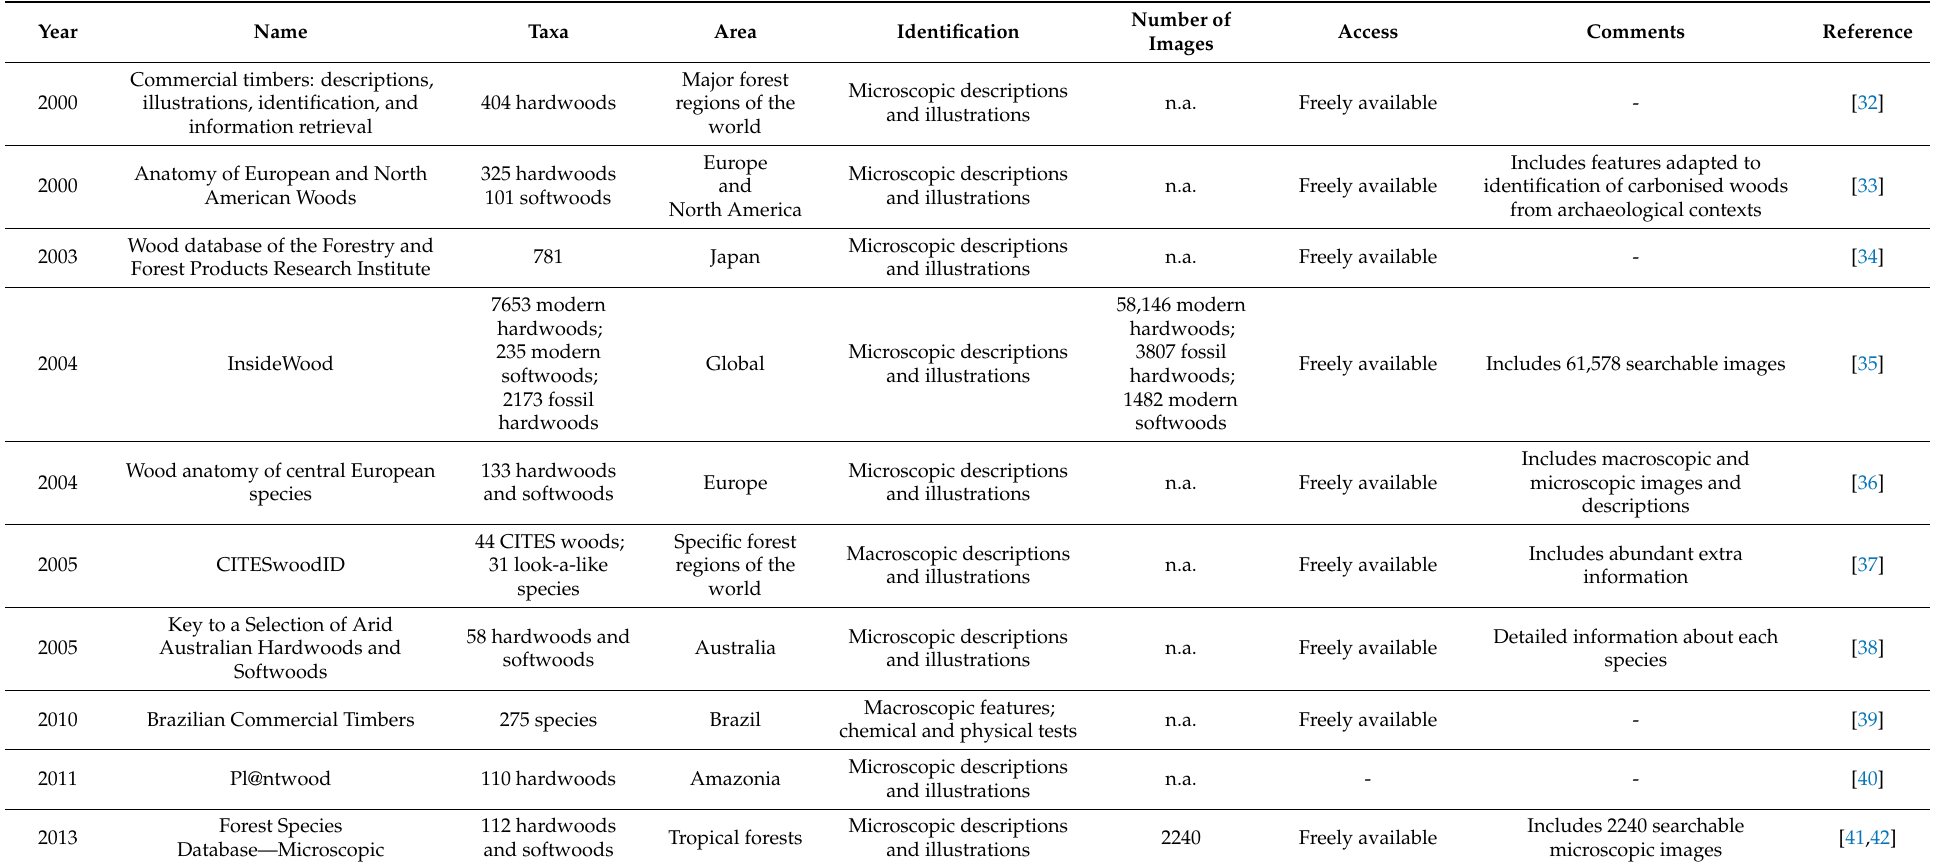
Table 1. Summary of computer-assisted wood identification